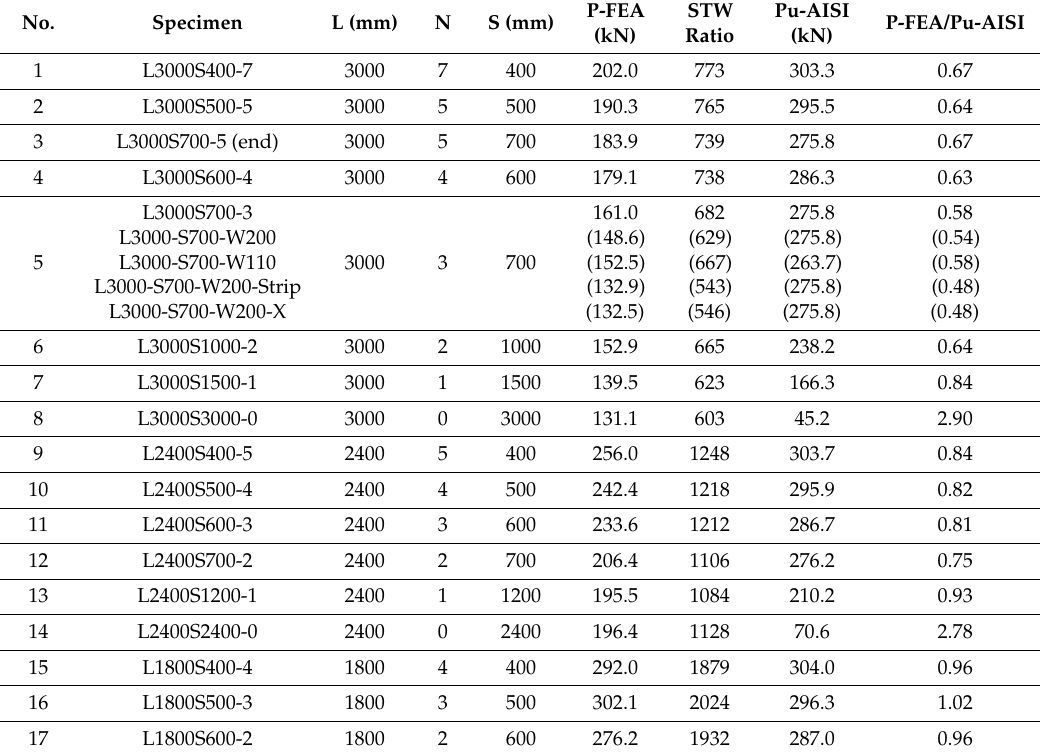
Table 4. Strength-to-weight (STW) ratio of built-up columns and comparison between numerical results and design strength according to